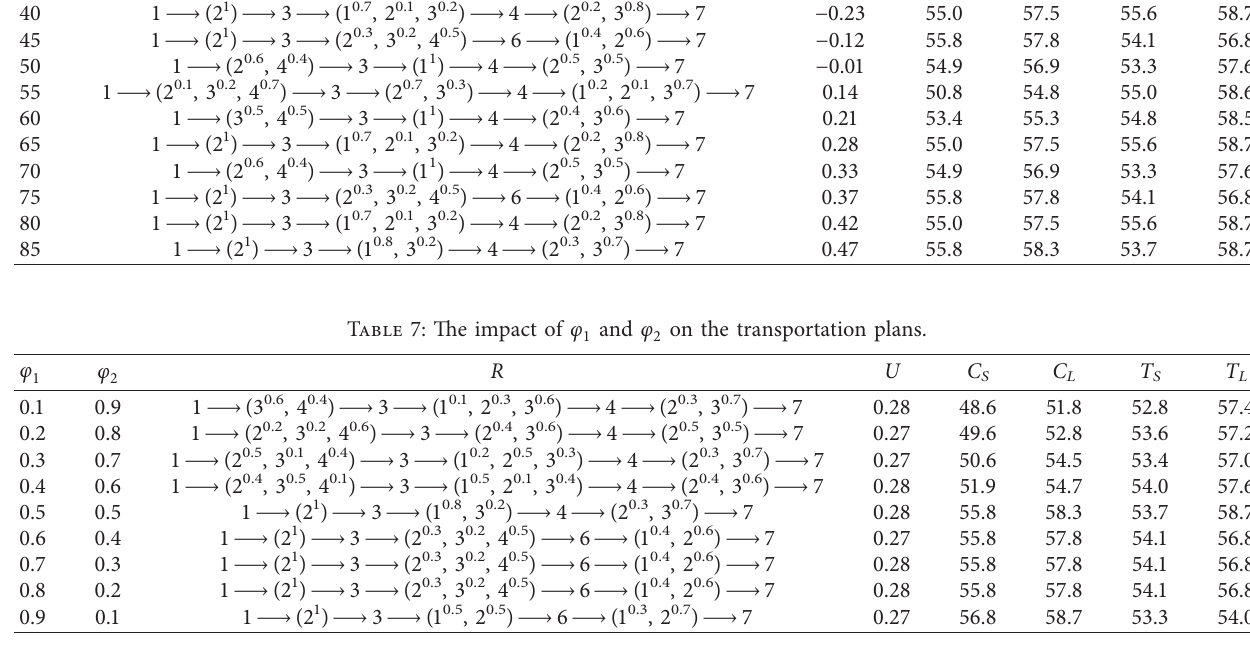
Table 8: Model parameter combination and the best utility of different node cases.